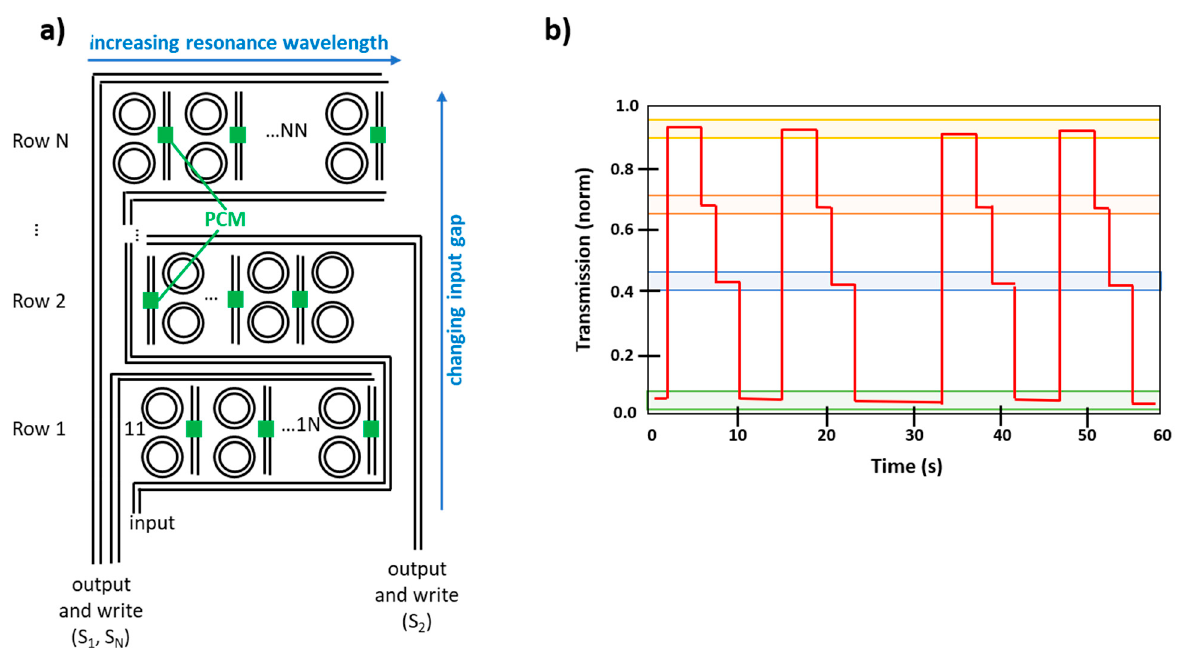
Figure 16. ( a ) Sketch describing the operation principle of the photonic memory proposed by Feldmann et al. [114]. Several PCM-cells are combined into rows and can be addressed individually; ( b ) Multilevel operation of a single memory cell. The phase-change material can be reversibly switched between four clearly distinguishable levels, characterized by different transmissions.